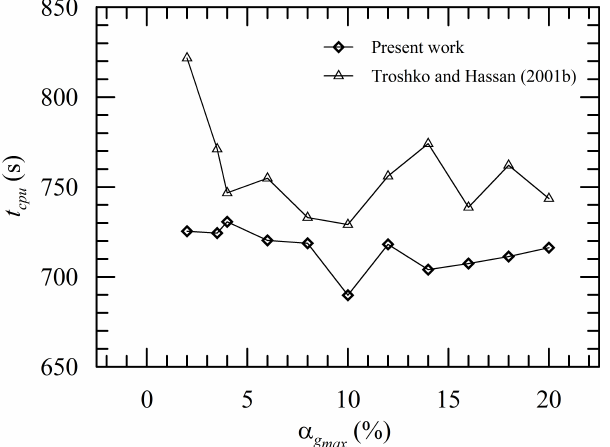
Figure 4 - Computational